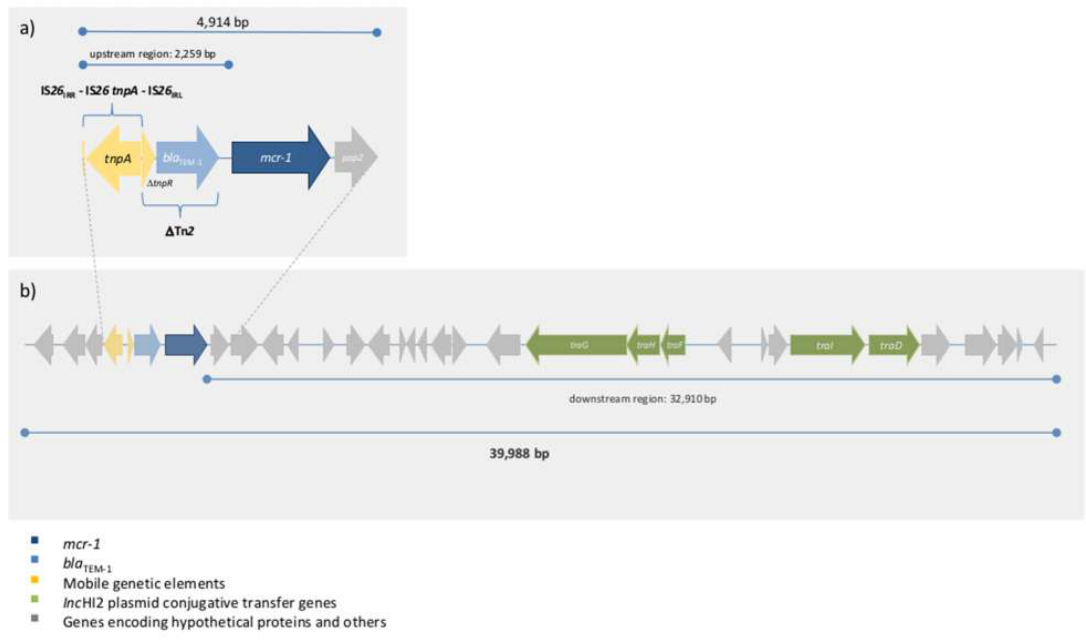
Figure 1. Schematic representation of mcr-1 gene flanking regions ( a ) mcr-pap2 element and upstream region including the antibiotic resistance gene bla TEM-1 . ( b ) contig region enclosing mcr-1 gene. Alignment of pINSali25-MCR contig to complete plasmids from Microbial Nucleotide